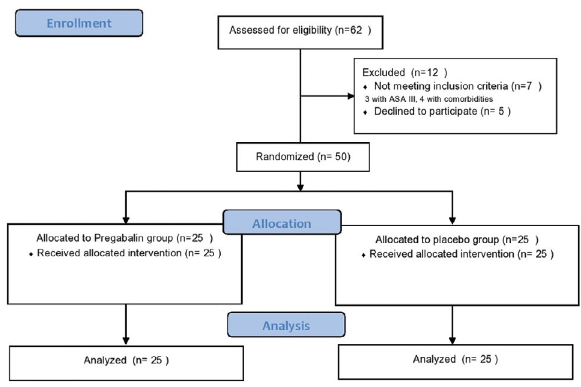
Figure 1: Flow chart of the participants in the study